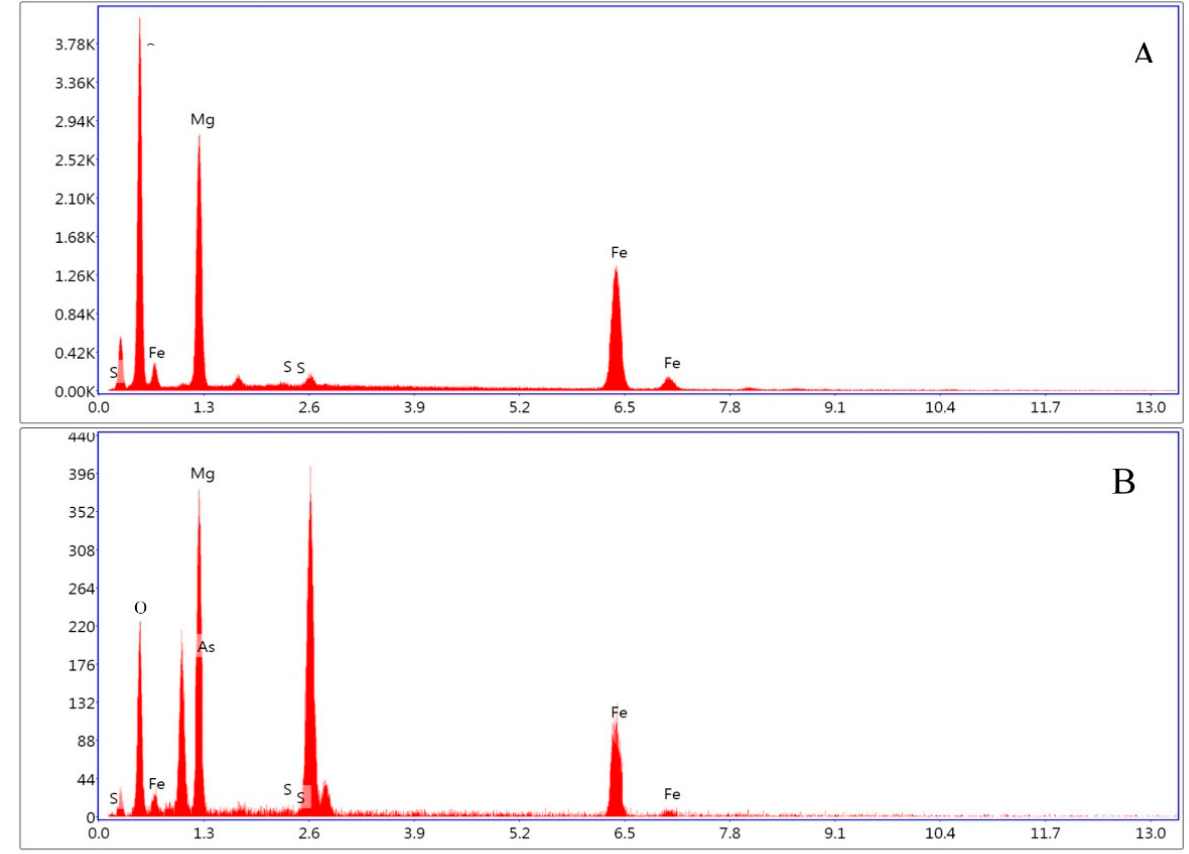
Figure 4. Line scan image of EDS (iowaite ( A ) and iowaite-NaAsO 2 ( B )).